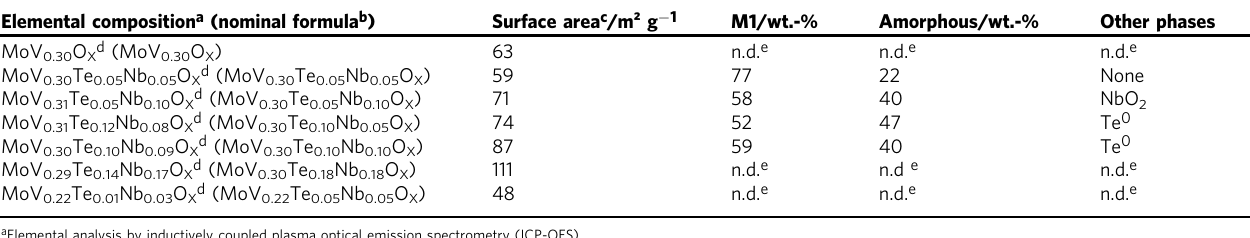
Table 1 Properties of a series of MoVTeNbO x materials prepared by the new method Elemental composition a (nominal formula b )